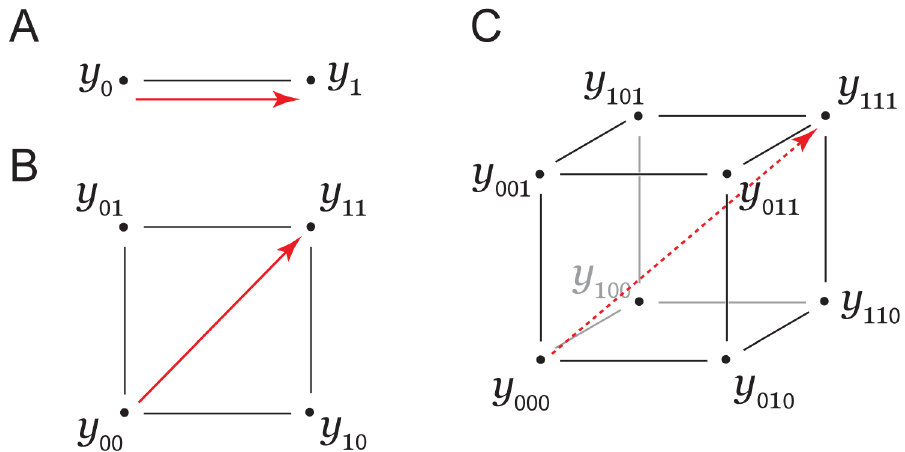
Fig 1. Definitions of genotype, phenotype, and effects of mutations. Representation of (A) single mutant, (B) double mutant, and (C) triple mutant experiments. Phenotypes are denoted by y g , where g is the underlying genotype. g = { g N , ... , g 1 } with g i 2 {0,1}; “ 0 ” or “ 1 ” indicates the state of the mutable site (e.g., amino acid position). The effect of a single, double, and triple mutation is given by the red arrows. Pairwise (or second-order) epistasis is defined as the differential effect of a mutation depending on the background in which it occurs; for example, in (B) it is the degree to which the effect of one mutation (e.g., y 10 − y 00 ) deviates in the background of the second mutation ( y 11 − y 01 ). Thus, the expression for second-order epistasis is ( y 11 − y 10 ) − ( y 01 − y 00 ). The third order and higher cases are considered in the main